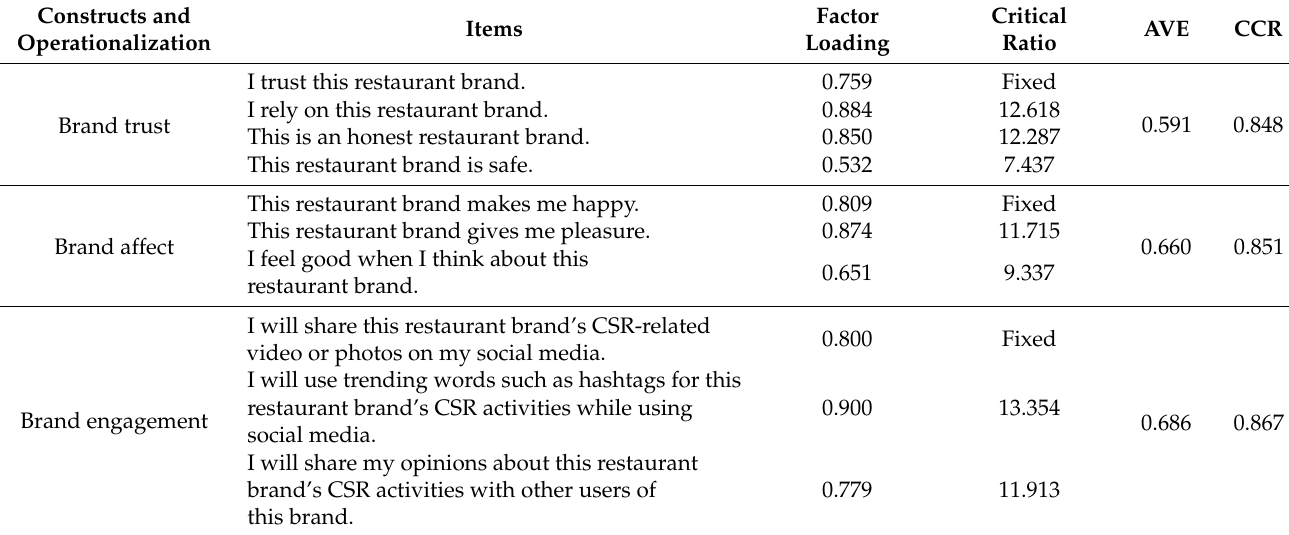
Table 1. Results of CFA, AVE, and CCR for experiment